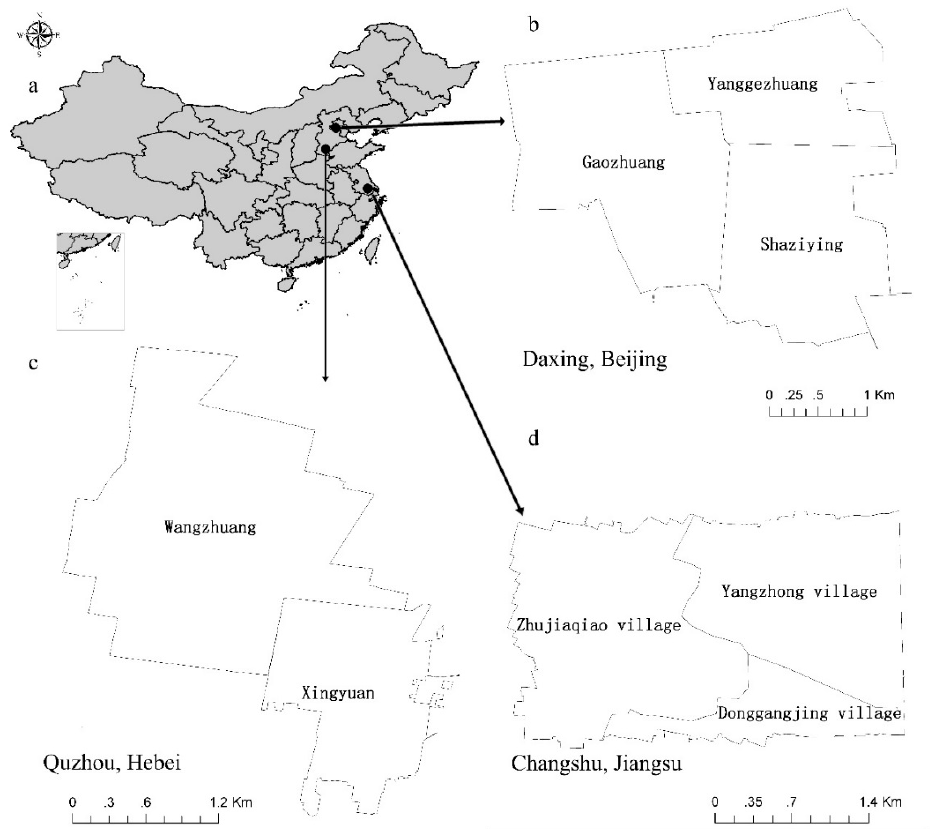
Figure 1. Map of study areas: ( a ) Study locations in China; ( b ) In DX, three villages, Yanggezhuang, Gaozhuang and Shaziying, had a total area of 707.45 ha; ( c ) The QZ study area comprised the two villages of Wangzhuang and Xingyuan, with a total area of 472.36 ha; ( d ) CS contained the three villages of Zhujiaqiao, Yangzhong and Donggangjing, with a total area of 588.08 ha.